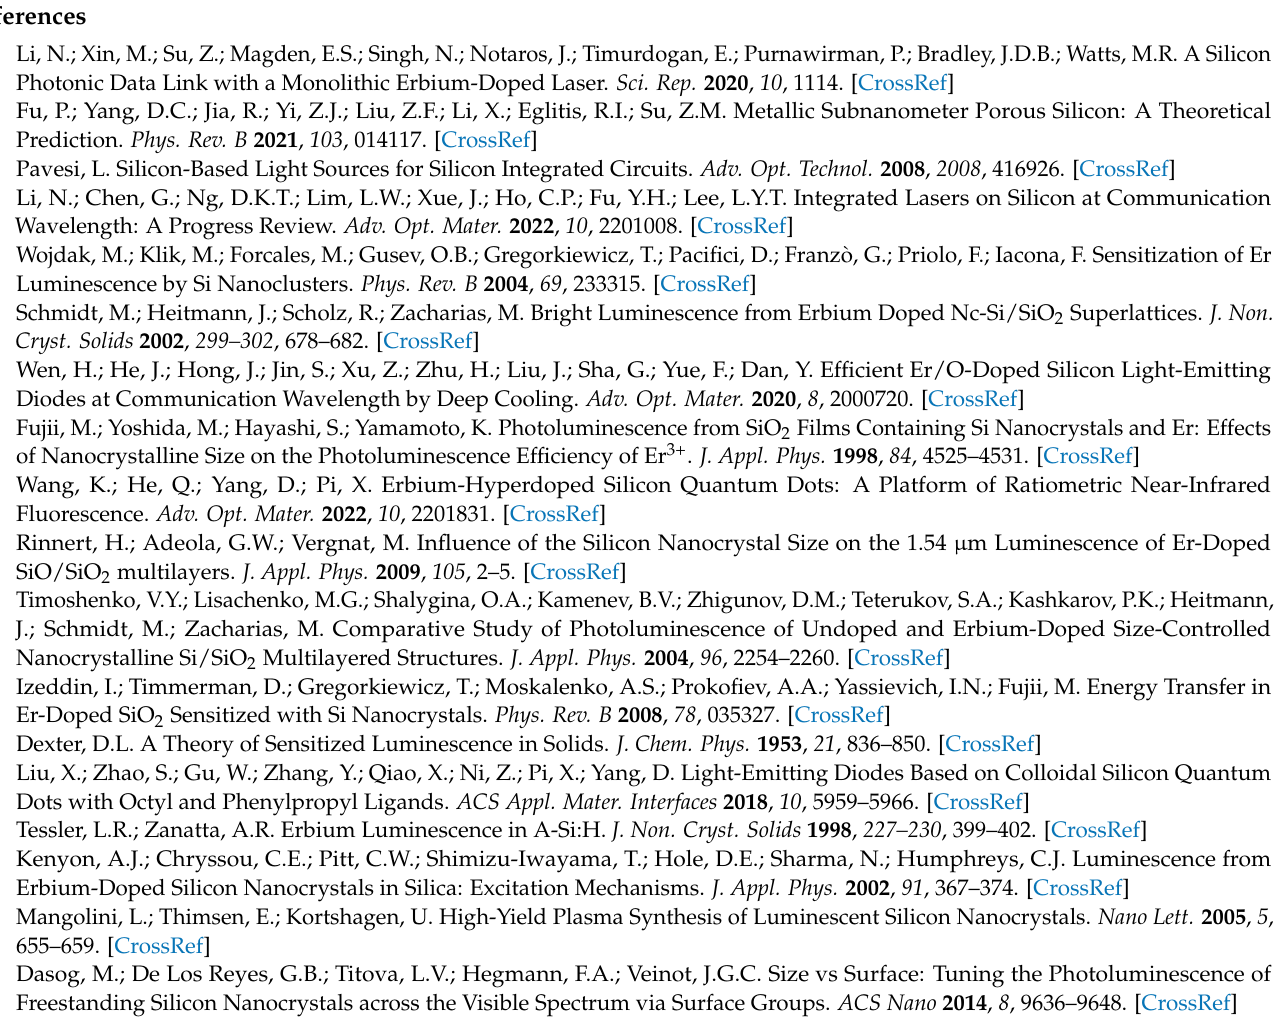
Si QDs; Table S1: Atomic fraction of various charge states of Si; Note S1: The fitting of PL decay curves and the determination of PL lifetime. Reference [9] is cited in the supplementary